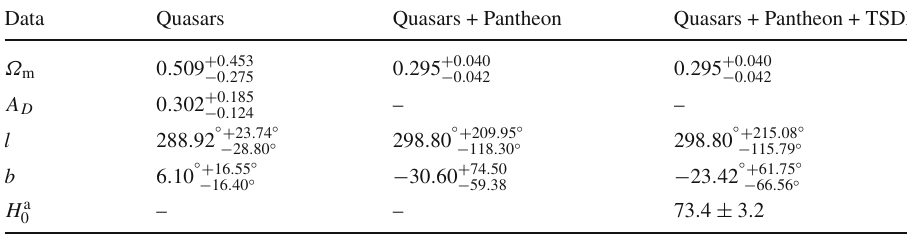
Table 2 The 68% confidence level constraints on the parameters in the Finslerian cosmological model with the 2015 quasar compilation and other datasets